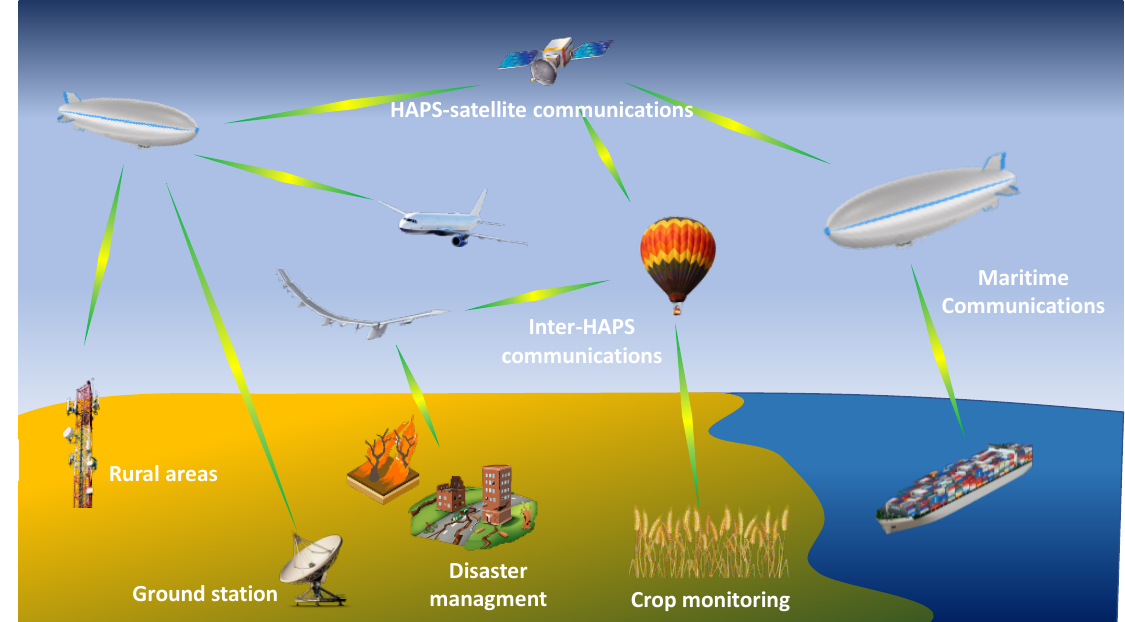
Figure 1. Examples of several scenarios where HAPSs can be exploited. The antenna system certainly represents one of the most important factors for HAPSs where reliable performance is concerned [28]. In Reference [29] a multibeam lens antenna for a HAPS operating at L/S band is presented. A Ka-band phased array composed